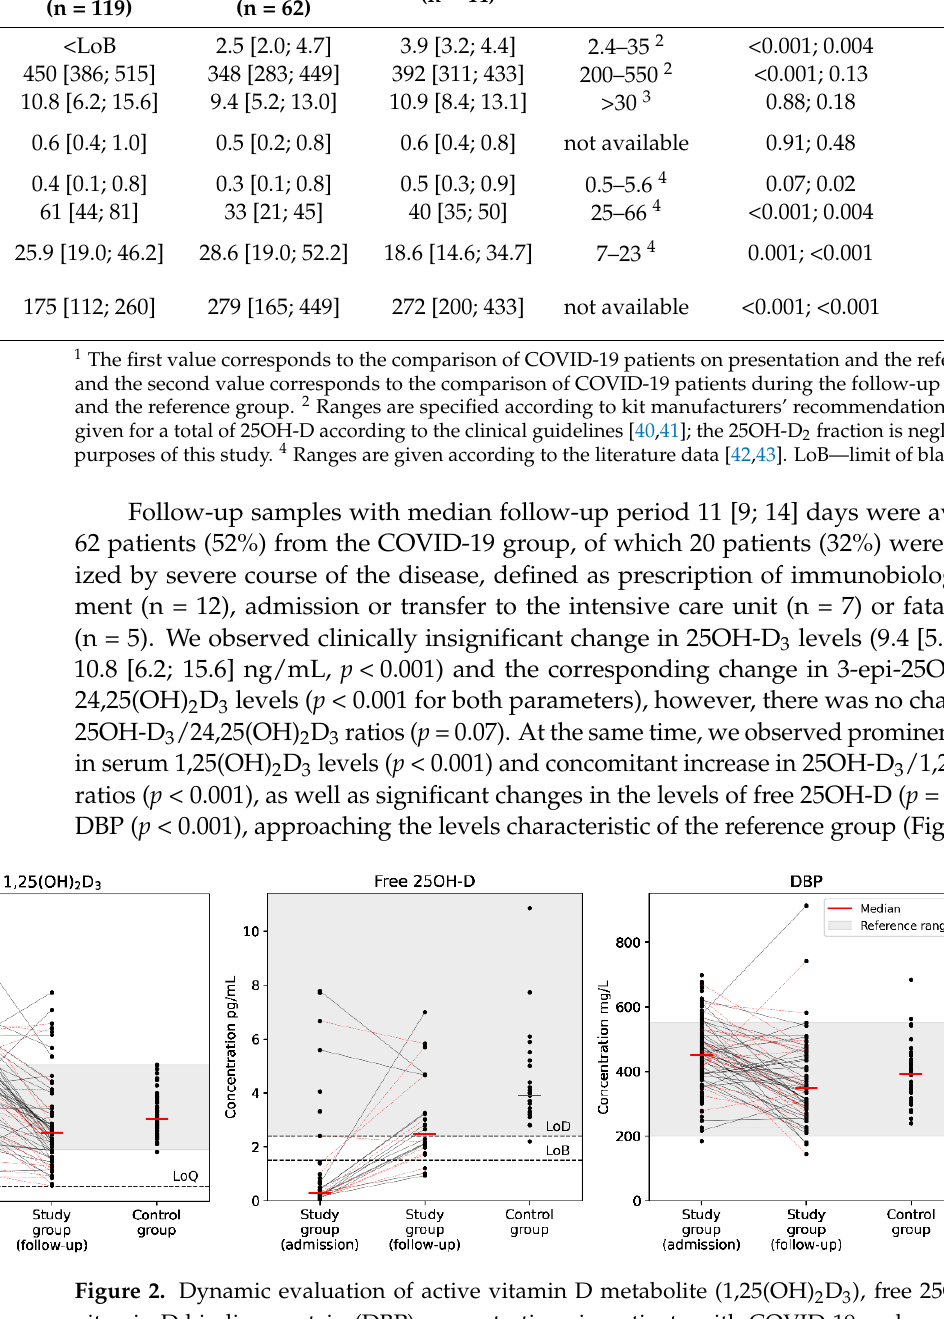
Table 5. Comparison of subgroups of COVID ‐ 19 patients depending on the severity of the disease. Laboratory Parameter